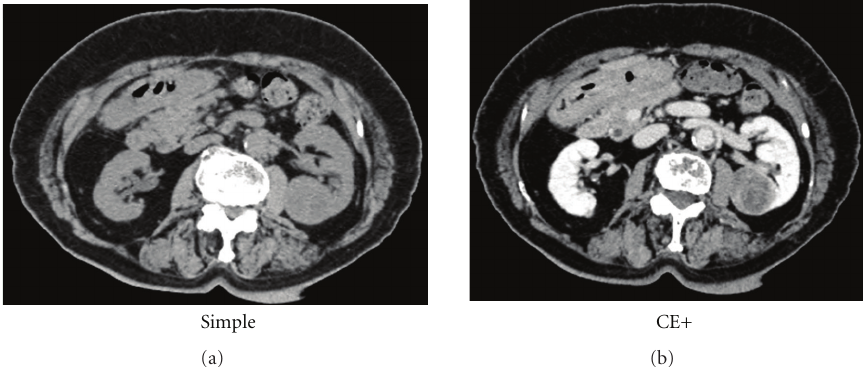
Figure 1: Computed tomography at the time of diagnosis. It showed a heterogeneously enhanced left renal mass 35 mm in diameter.